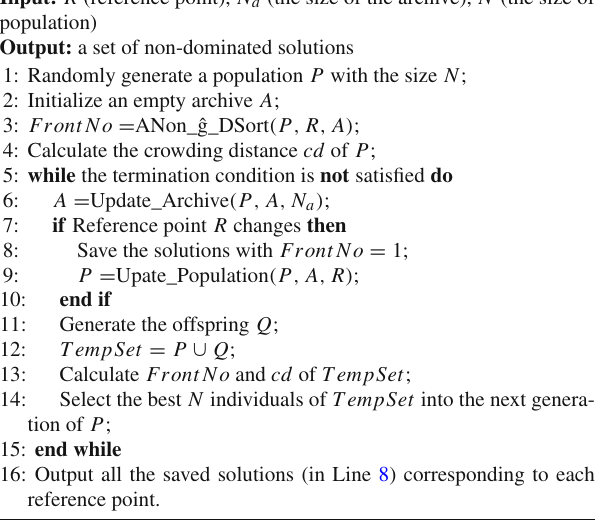
Algorithm 4 Algorithm